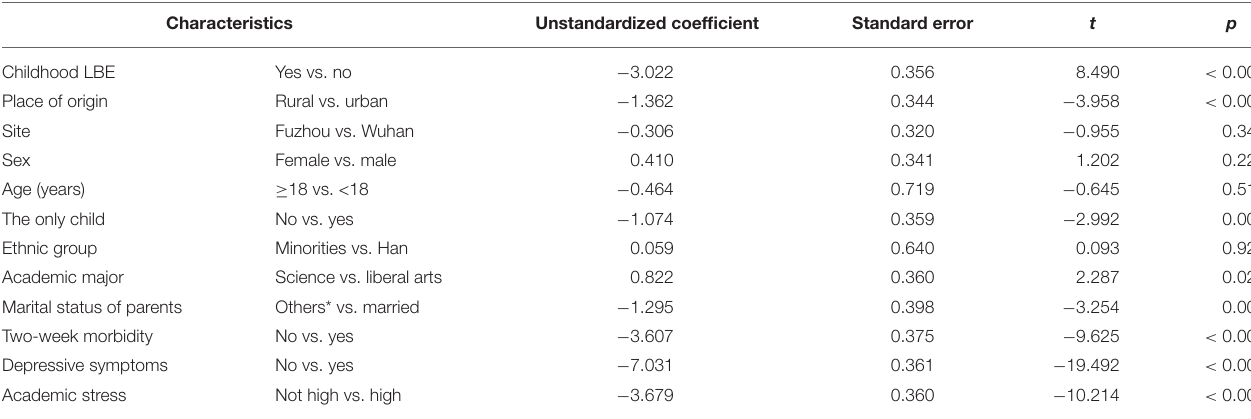
TABLE 2 | Multiple linear regression on relationship between childhood left-behind experience (LBE) and quality of life (QOL) among freshmen, adjusting for the confounding effects of sociodemographic variables, physical health, depressive symptoms, and academic